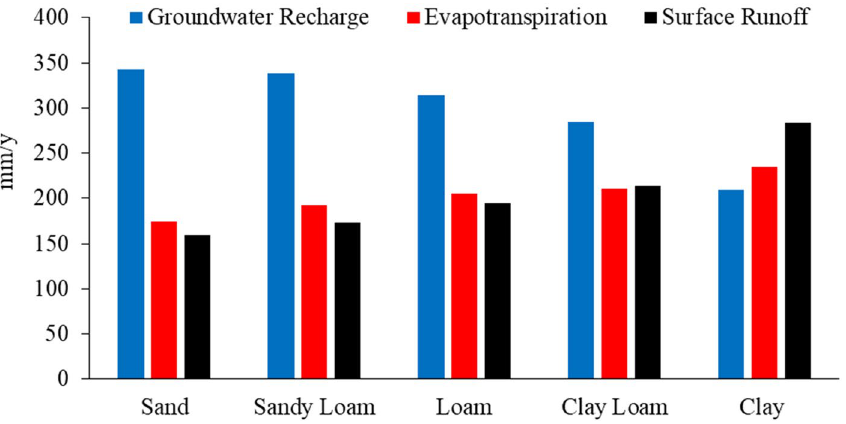
Figure 10. Average annual groundwater recharge, evapotranspiration, and runoff as a function of soil texture for LULC in 2018.